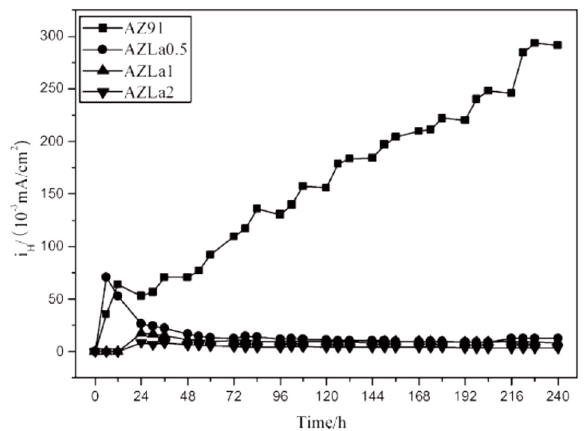
Figure 31. Corrosion current densities ( i H ) of AZ91 alloy varied with different immersion time. Reproduced with permission from [160], John Wiley and Sons, 2009.